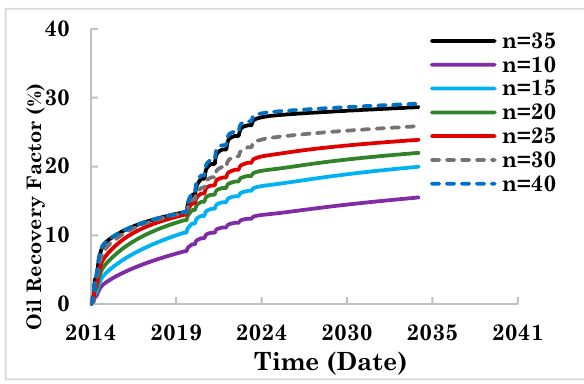
Figure 11. C 2 H 6 Injection (Extended Cycle Size) 38 API Oil.